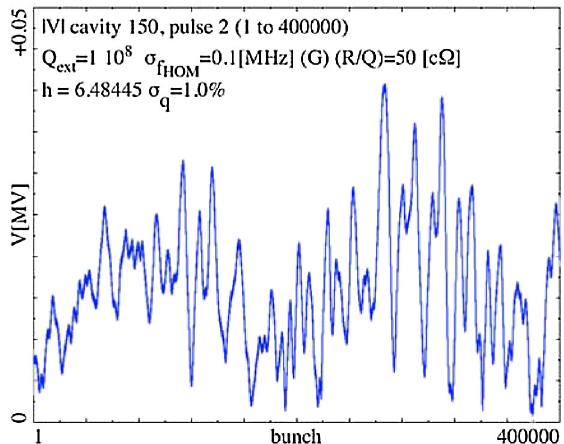
FIG. 67. (Color) The voltage of the first cavity (#1) (2nd beam pulse) from passage of bunch 1 to 400 000, the ‘‘succession’’ of Fig. 65 after the beam-pulse pause. The voltage does not start at zero but at the remainder of the 1st pulse after the beam-pulse pause.